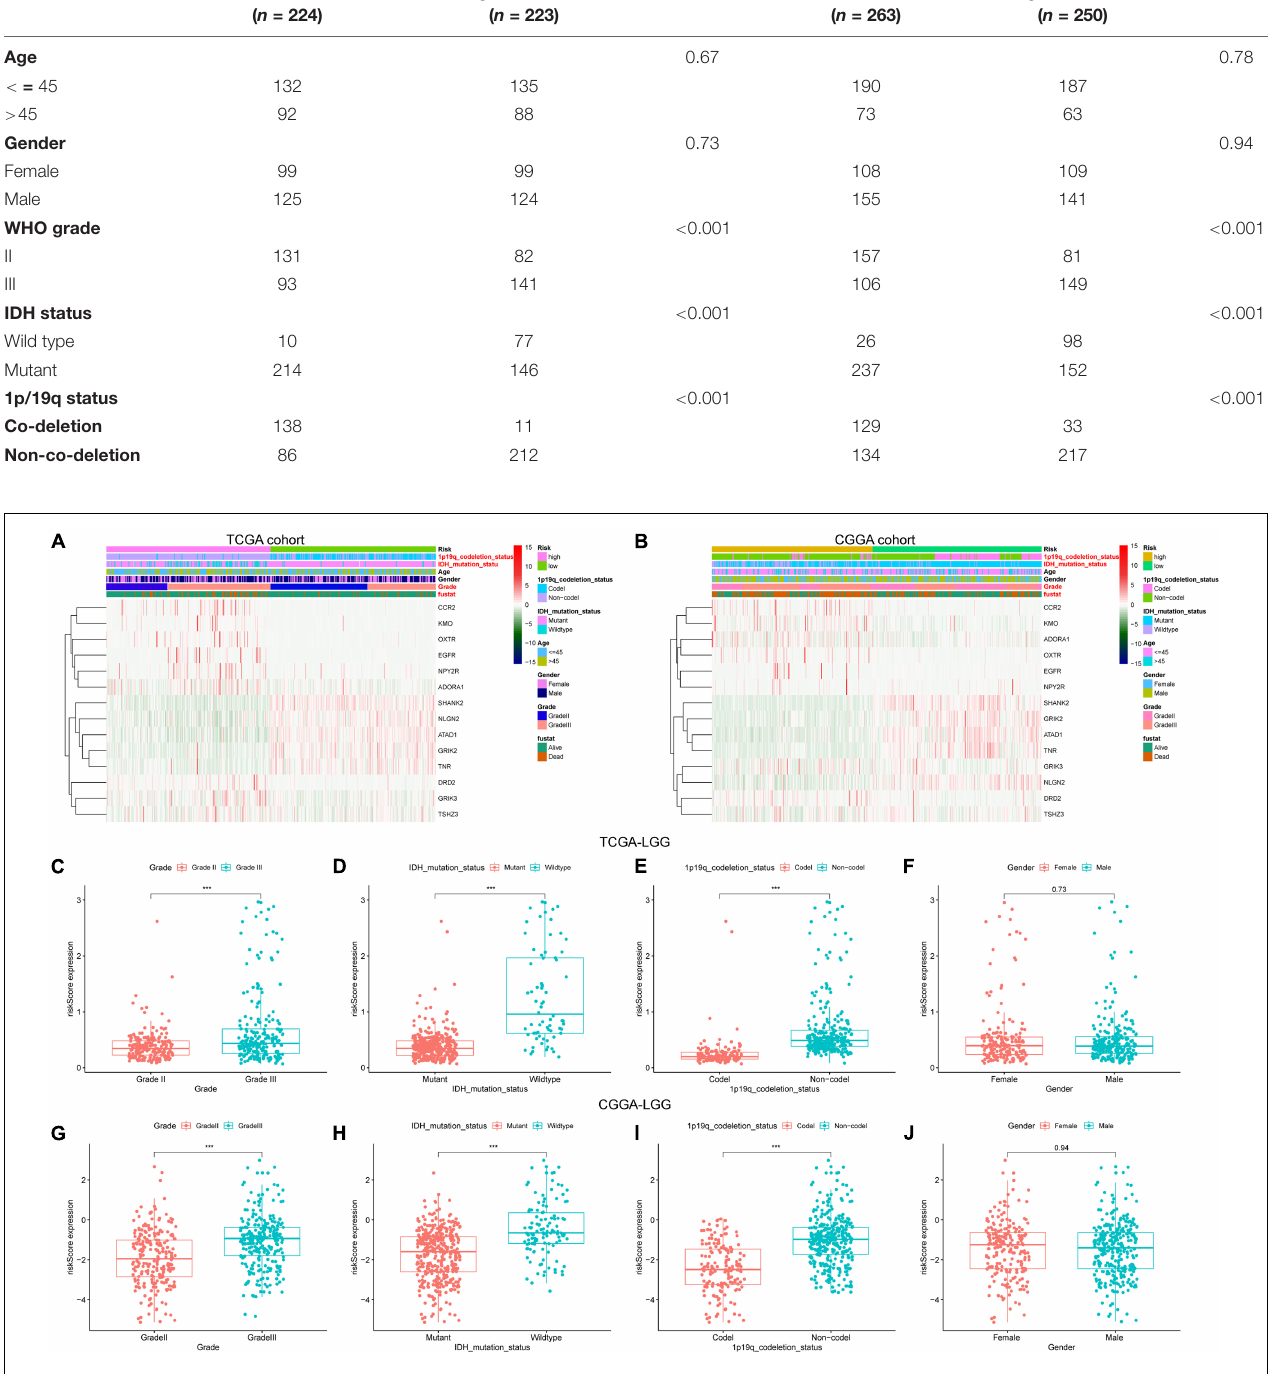
FIGURE 4 | The association between risk score and clinicopathological factors. Heatmap of the correlations between risk score and clinicopathological characteristics of LGG in TCGA (A) and CGGA (B) cohorts; factors with red color are significantly correlated with the risk score. Distribution of glutamatergic synapses-related risk signature among LGG patients stratified by WHO grade, IDH status, 1p/19q co-deletion status, and gender in TCGA (C–F) and CGGA (G–J) cohorts. *** p < 0.001.